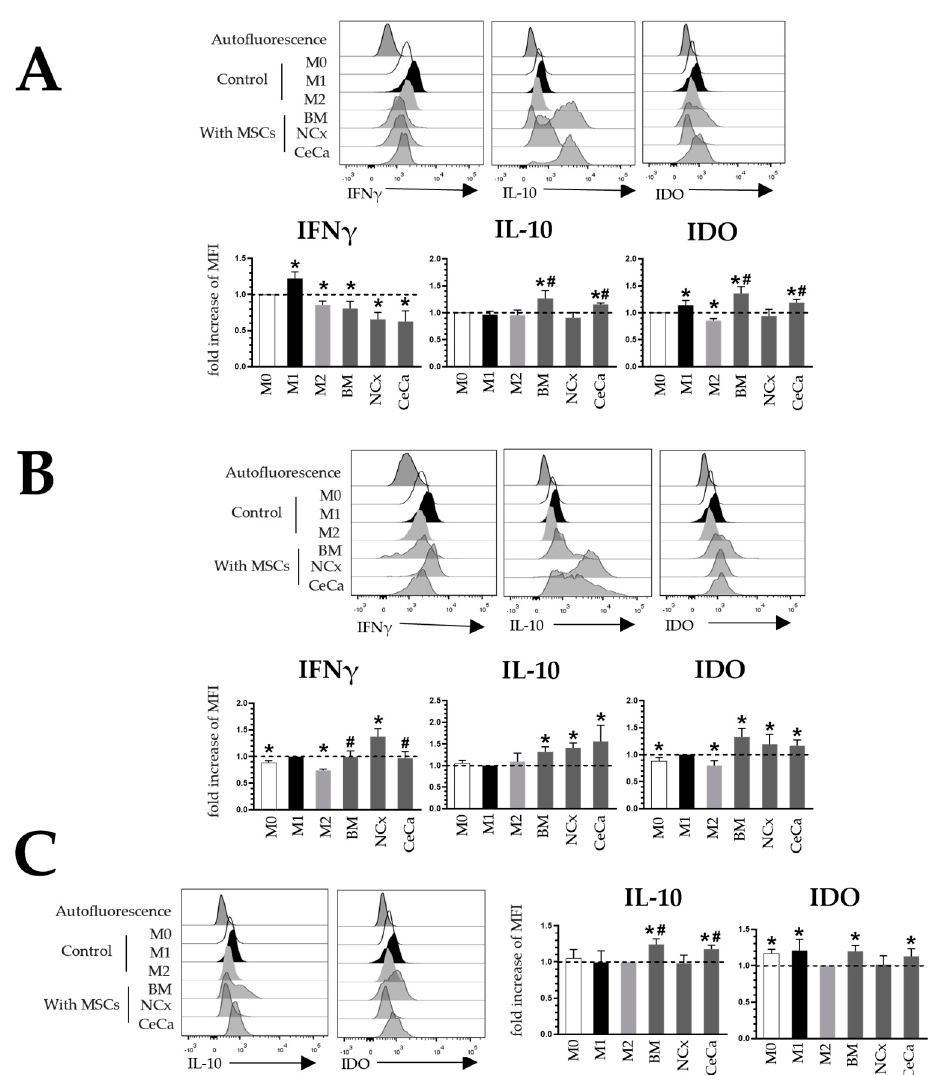
Figure 3. Coculture with CeCa-MSCs and BM-MSCs increases the intracellular expression of IL-10 and IDO in macrophages. ( A ) Representative histograms and bar graphs of the fold increase with respect to the M0 control for intracellular molecules in macrophages cocultured with MSCs in the absence of inducer medium. ( B ) Representative histograms and bar graphs of the fold increase with respect to the M1 control for intracellular molecules in macrophages cocultured with MSCs in the presence of M1 inducer medium. ( C ) Representative histograms and bar graphs of the fold increase with respect to the M2 control for intracellular molecules in macrophages cocultured with MSCs in the presence of M2 inducer medium. Bar graphs represent the mean and standard deviation. * Significant difference with respect to the control, # significant difference with respect to NCx-MSCs ( p < 0.05); n = 6. M0, absence of inducer medium; M1, inducer medium for M1 polarization; M2, inducer medium for M2 polarization.